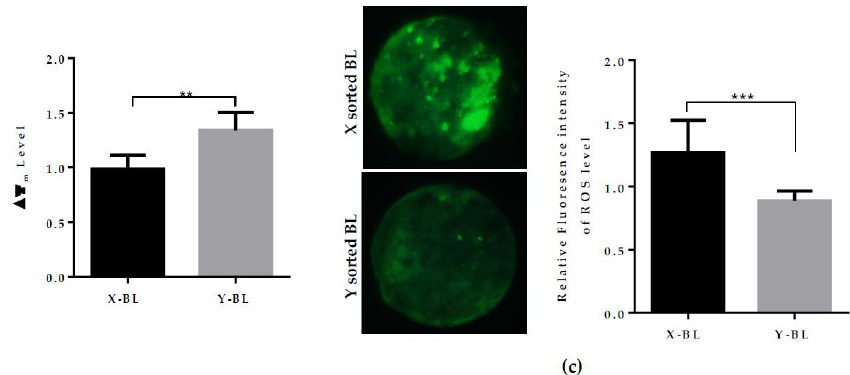
Figure 2. Di ff erence in mitochondrial distribution, ∆Ψ m , and ROS level during the development of X- and Y-sorted BLs. ( a ) Representative images of Mitotracker (Red) staining showing X-BL with semiperipheral and Y-BL with homogeneous distribution patterns of mitochondria. Data in graph represent the percentage of homogeneously distributed mitochondria in the X- and Y-BL groups. ( b ) Expression of J-monomer (green) and J-aggregates (red) was analyzed by JC-1 staining to measure the mitochondrial ∆Ψ m in X- and Y-BL using confocal microscopy. Quantification for relative fluorescence intensities in both X- and Y sperm-derived BLs are presented in graph. ( c ) DCHDFA (2’, 7’-dichlorodihydrofluorescein diacetate) staining for the generation of ROS level in X- and Y-BL. Quantification of fluorescence intensities is shown in graph. Bar graphs represent means ± SEM from three separate experiments with day seven BLs, n = 15 per group in individual sets of assays. ** p < 0.01; *** p < 0.001. Original Magnification 100×.